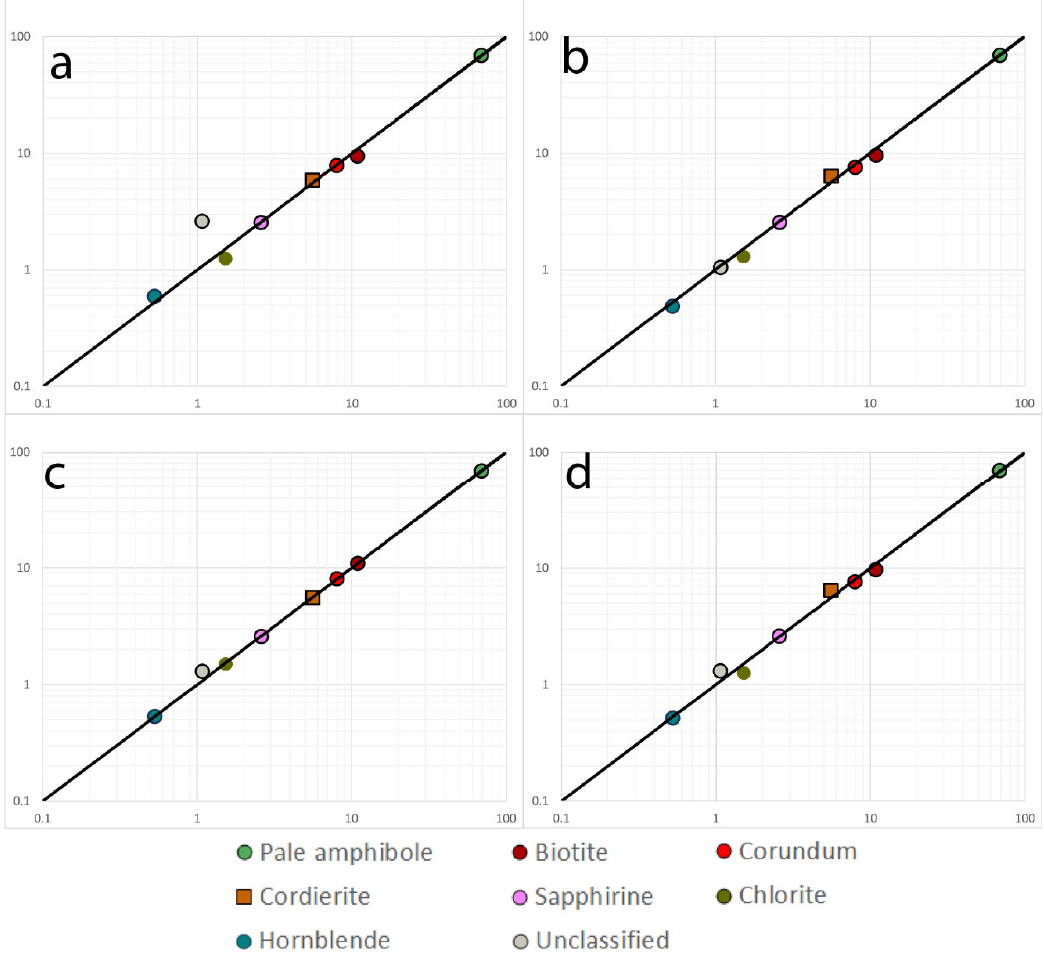
Figure 5. Logarithmic diagrams showing the correlation between different analysis methods (y-axis) and 5 µm step size mapping (x-axis). Data is shown as area %. ( a ) 20 µm step size line-scan. ( b ) 40 µm step size mapping. ( c ) 20 µm step size mapping. ( d ) 10 µm step size mapping.